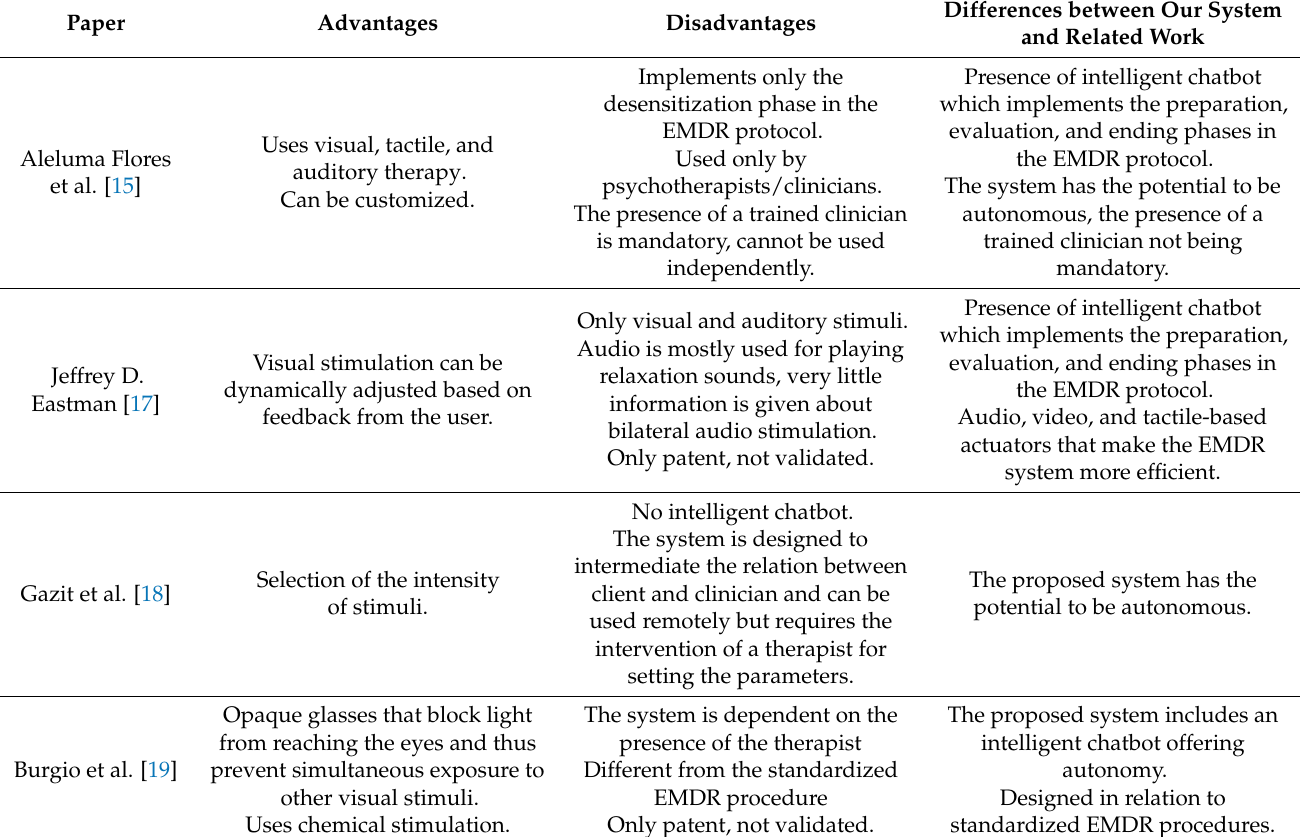
Table 1. Comparison with similar systems in the